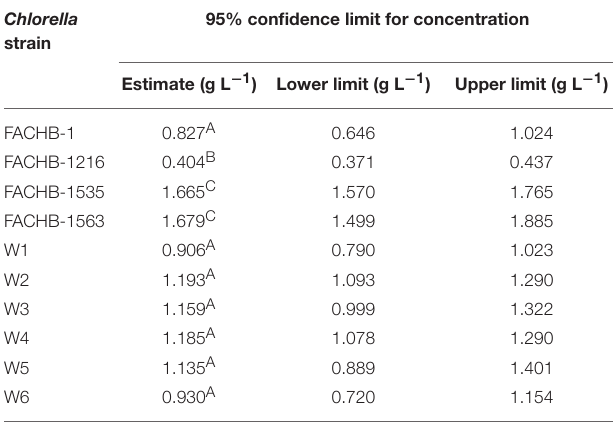
95% confidence limit for concentration